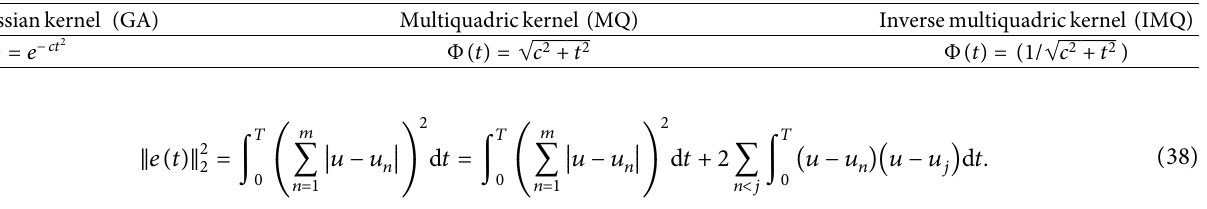
Figure 1: One-dimensional case of the considered stencil. Table 1: The most popular radial